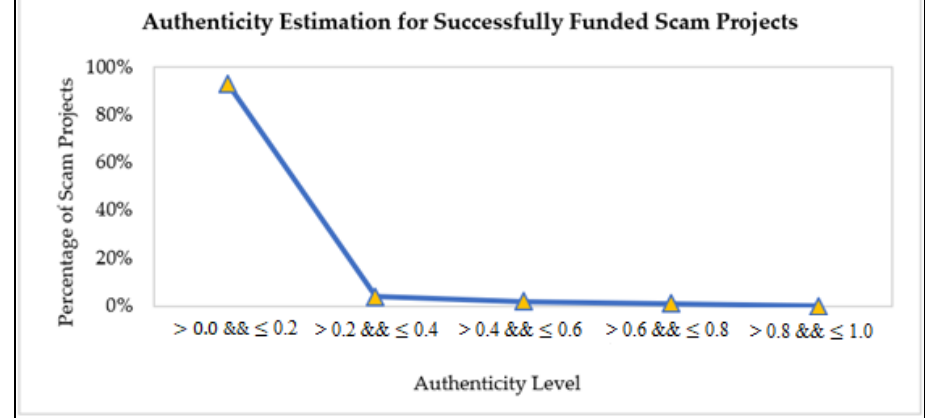
Figure 7. Authenticity estimation for successfully funded scam projects.